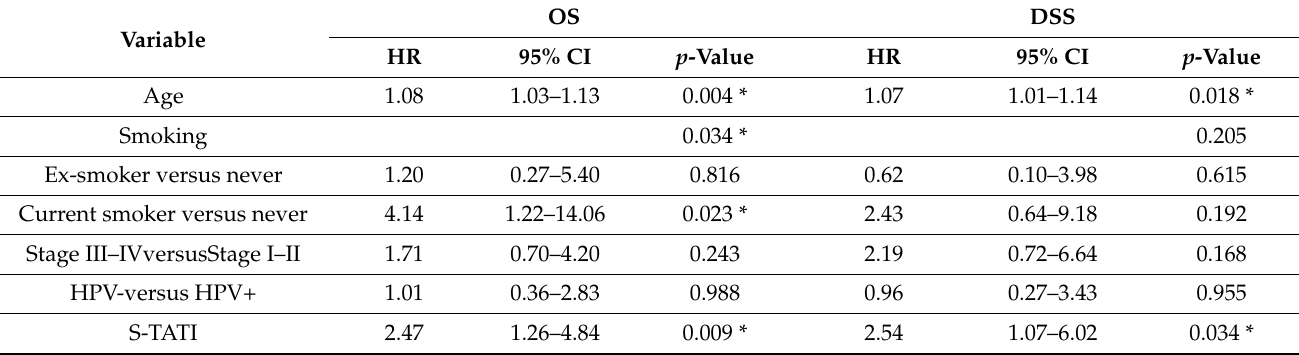
Table 2. Multivariate Cox regression analysis for overall-survival (OS) and disease-specific survival (DSS).